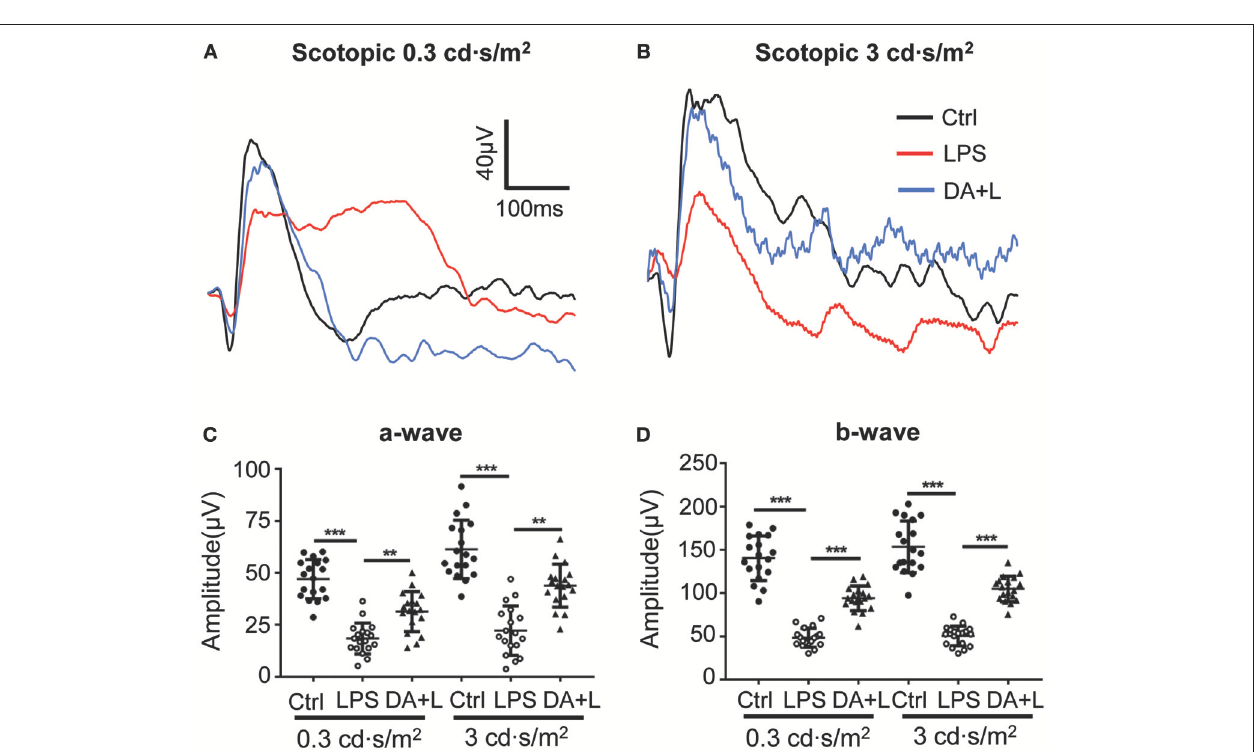
FIGURE 4 | DAPT treatment attenuated the impairment of the retinal function induced by LPS. (A,B) Retinal function was evaluated by flash ERG under two light intensities. The amplitudes of a-wave and b-wave were significantly decreased 24h after LPS injection under two different stimuli intensities compared with those in the control group. However, DAPT treatment could markedly improve the amplitudes of a- and b-wave compared with that in the LPS group. Total 18 rats in each group were used for statistical analysis. (C,D) The dot plots of a-wave and b-wave under two light intensities. ** p < 0.01, *** p < 0.001 (one-way ANOVA). Ctrl, Control; DA + L, DAPT +